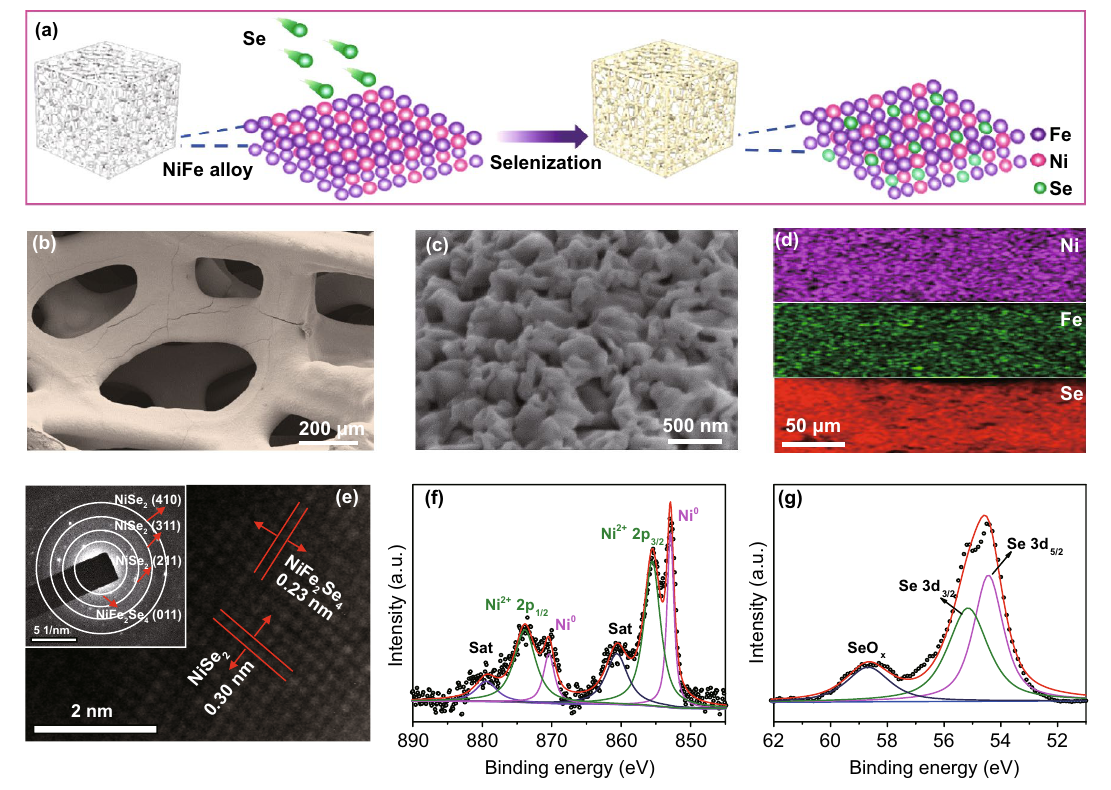
Fig. 1 a Schematic illustration for one-step fabrication strategy of NiSe 2 /NiFe 2 Se 4 @NiFe. b , c FESEM images of NiSe 2 /NiFe 2 Se 4 @NiFe. d EDX elemental mappings images of Ni, Fe, and Se elements in NiSe 2 /NiFe 2 Se 4 @NiFe. e HRTEM image of NiSe 2 /NiFe 2 Se 4 @NiFe; inset: cor- responding SAED pattern. High-resolution XPS spectra of f Ni 2 p and g Se 3d for NiSe 2 /NiFe 2 Se 4